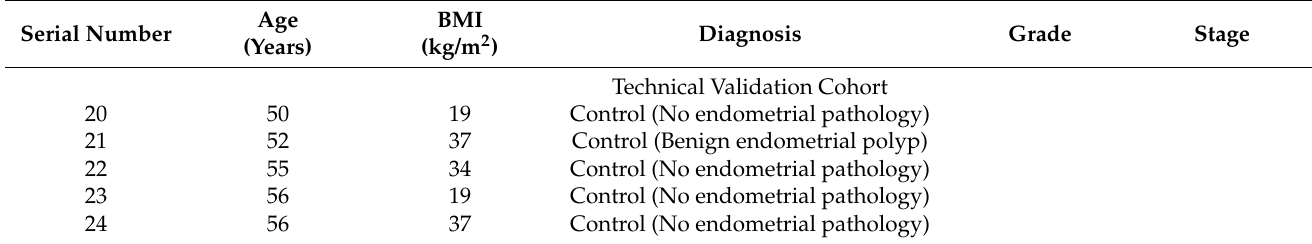
Table 5. Demographic and clinical characteristics of the technical and clinical validation